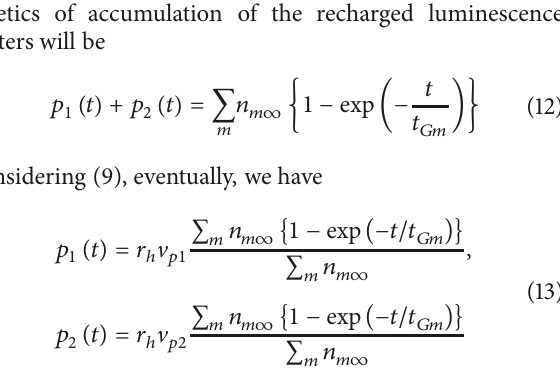
𝐼 = 0.64 mW/cm 2 ) we have almost similar peak intensities X 2 at the same radiation doses. That is, if 𝐼 X 1 ⋅𝜏 1 X = 𝐼 X 2 ⋅𝜏 2 X ,